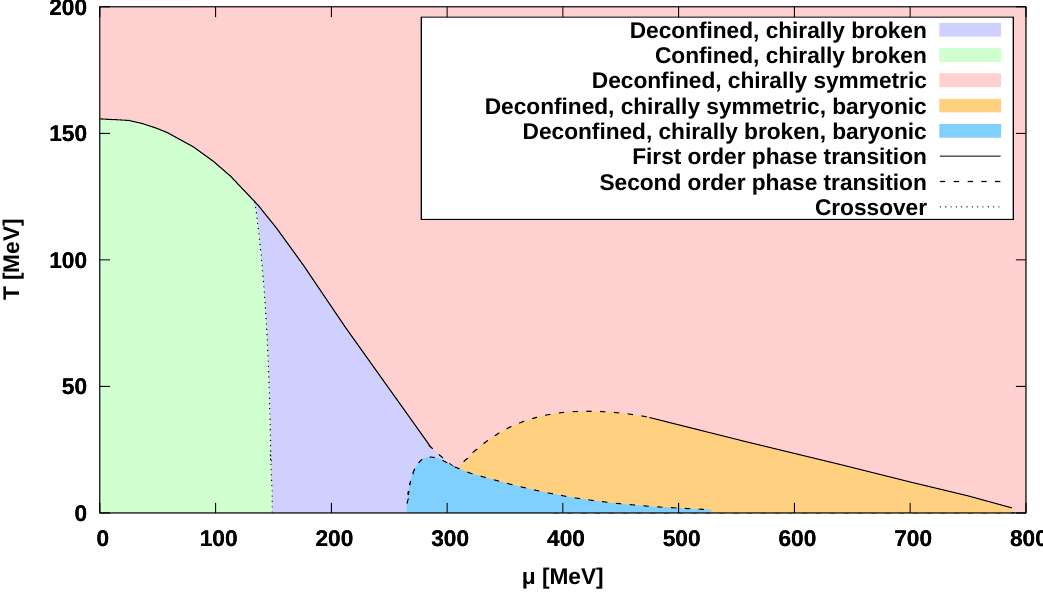
Figure 1 . The phase diagram for the thin layer approximation in the ( (cid:22); T )-plane. It can be seen that we have two phases in which baryon number charge is located outside the black hole. Note that due to numerical accuracy the phase transitions cannot be accurately continued to the (cid:22) -axis, but they do all reach